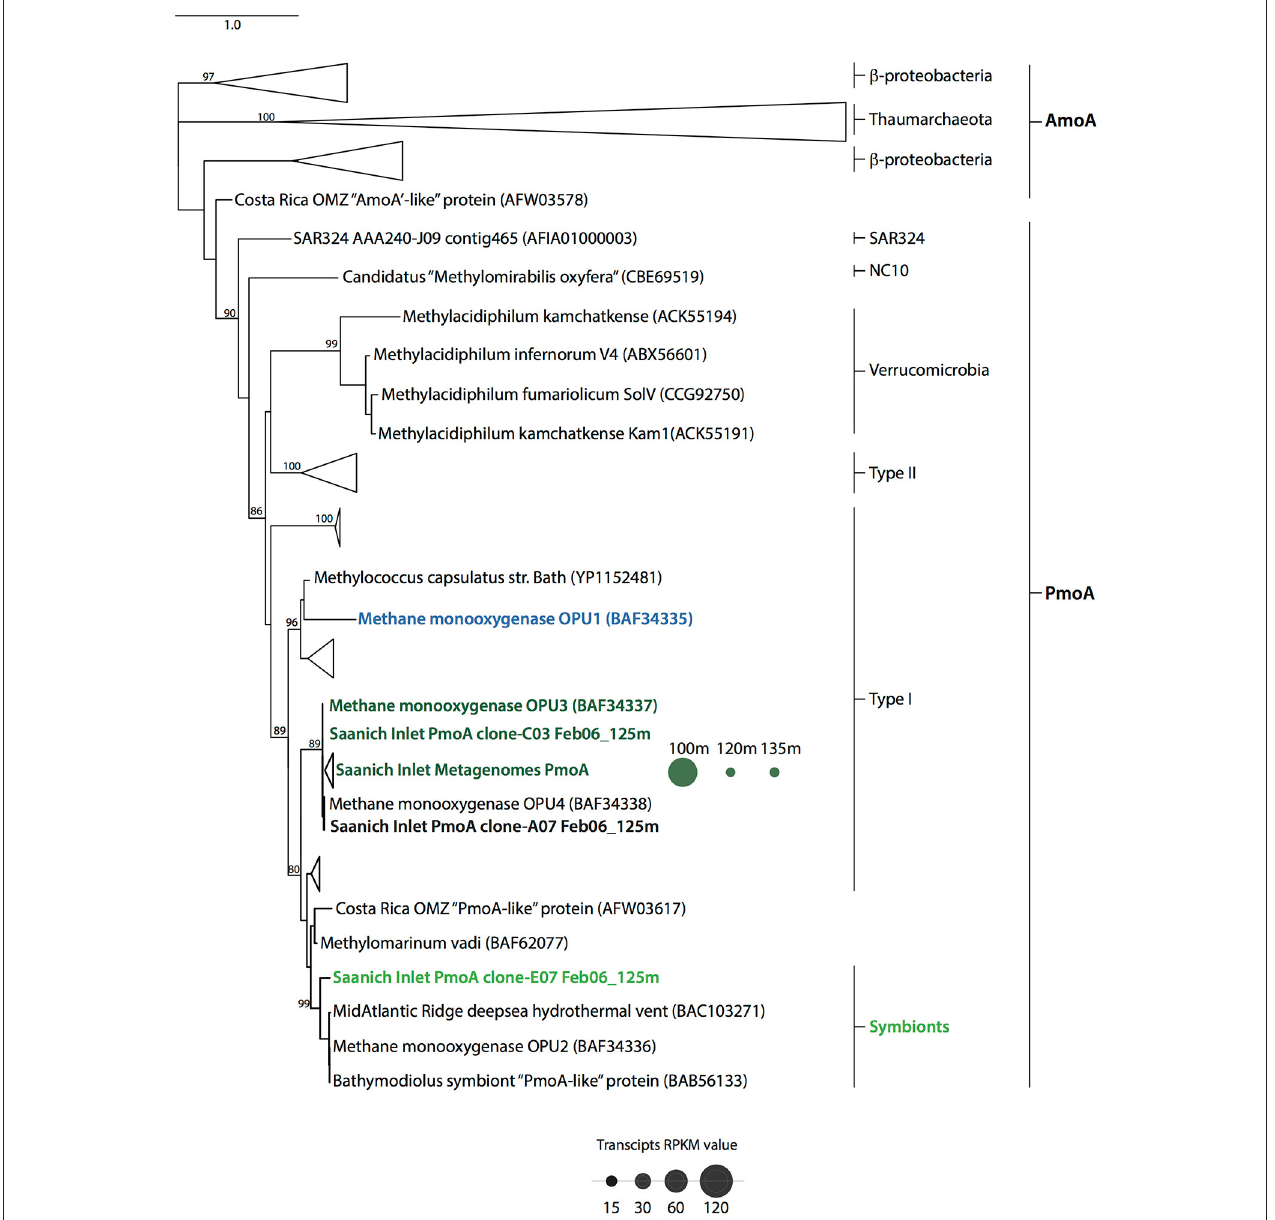
FIGURE 5 | Particulate methane monooxygenase subunit β ( pmoA ) phylogenetic tree. Topography was inferred using maximum likelihood on PmoA and AmoA amino acid sequences from reference sequences including pMMO-encoding groups OPU1 and OPU3, and symbionts. Bootstrap values (%) are based on 100 replicates and are shown for branches with greater than 70% support. The scale bar represents 0.5 substitutions per site. PmoA distribution throughout water column (100–135 m) is depicted as dots whose size represents the average RPKM value for February 2010 metatranscriptomic